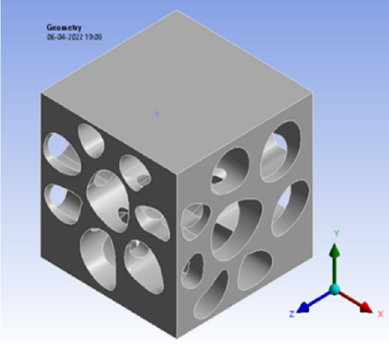
Figure 13. Walnut model view.